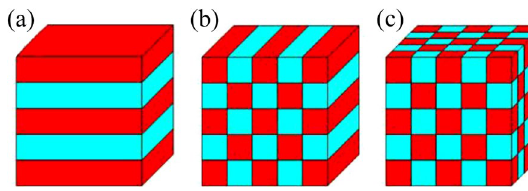
Figure 1 a One dimensional; b two-dimensional; and c three-dimensional photonic crystal structure